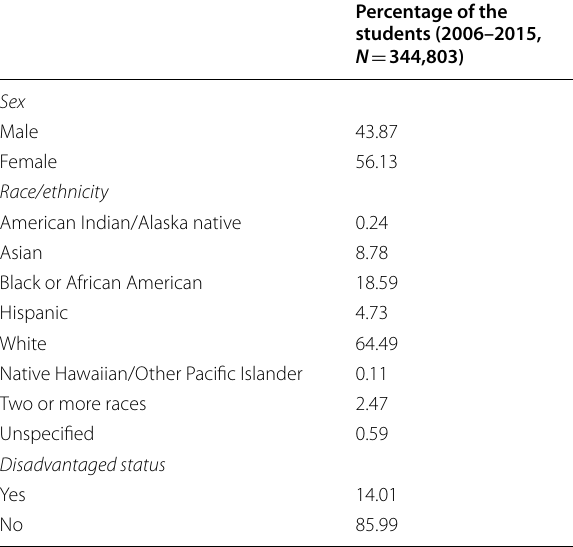
Table 1 High school senior year demographic information as percentages of the